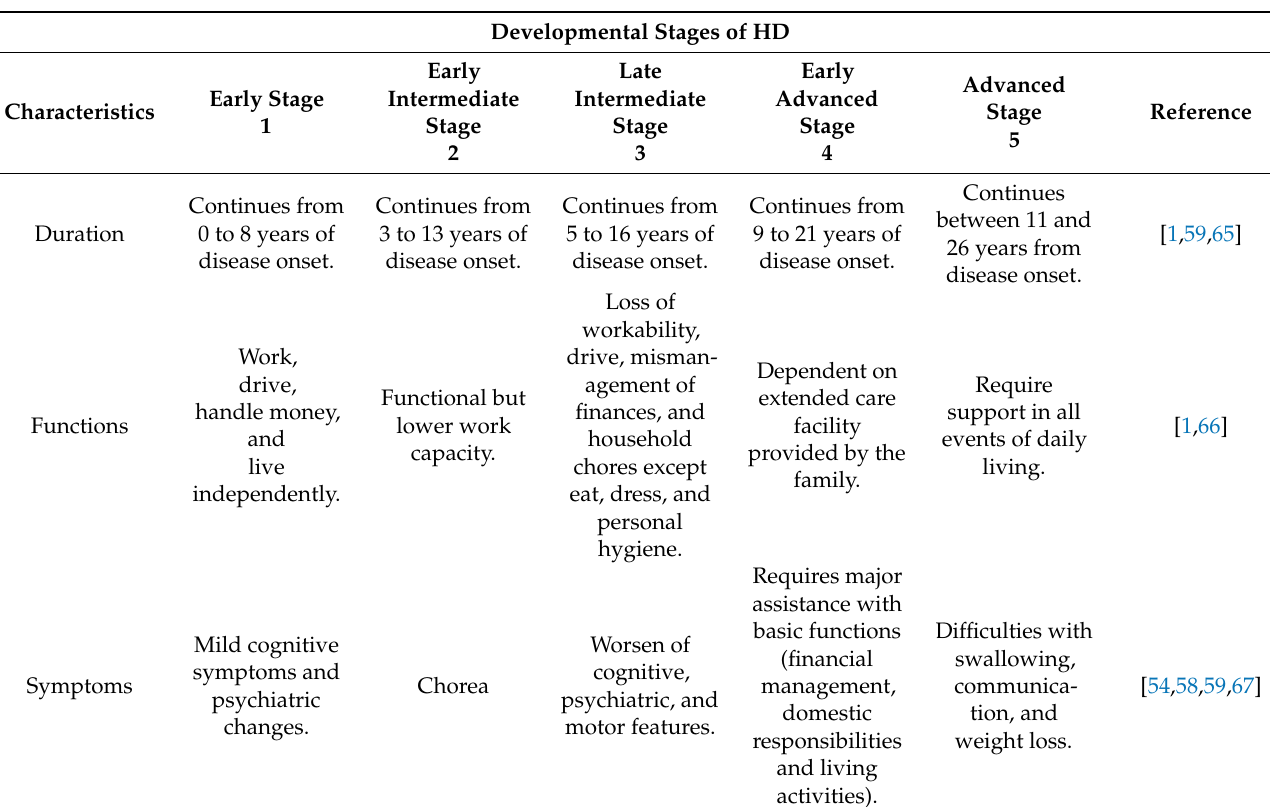
Table 2. Stages of